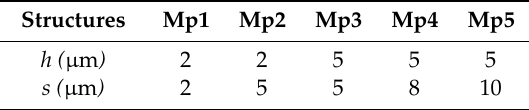
Table 1. Micropit size on the surface of microstructure.